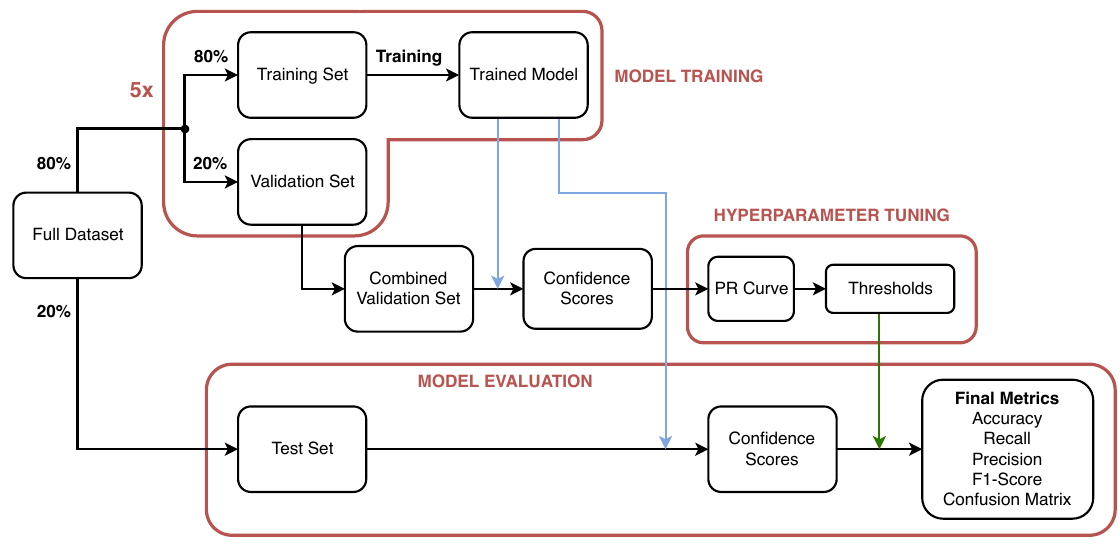
Figure 4. Model training and evaluation